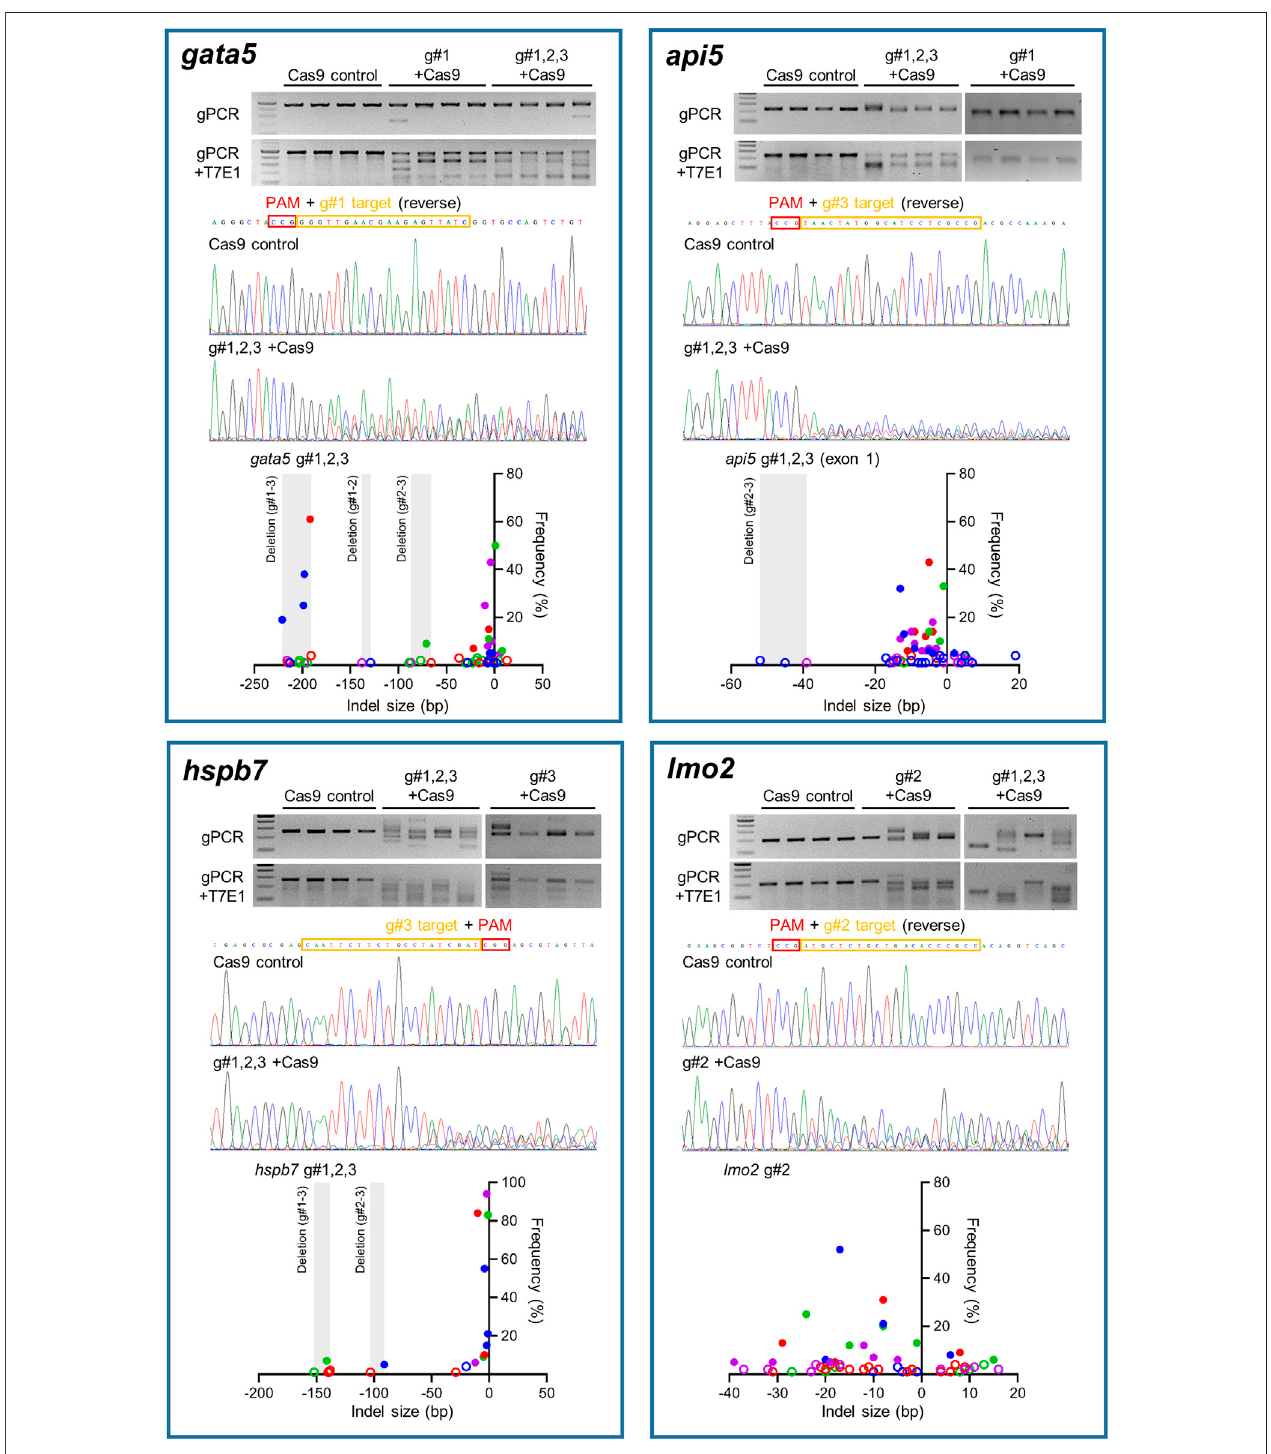
FIGURE2| Mutationef fi ciencyofthegRNAsforeachcandidategene.Datafor gata5 areshownintopleftpanel, api5 intoprightpanel, hspb7 inbottomleftpanel, and lmo2 in bottom right panel. In each panel, the upper gel images show the bands obtained following targeted PCR of genomic DNA extracted from four individual animals injected with the two most effective CRISPR gRNAs + Cas9 (based on 2 dpf morphological analysis), compared with the Cas9 injected control animals. The lowergelimagesshowthesamesamplesfollowingT7E1assayundertakentorevealthecleavageofheteroduplexDNA.Thechromatogramimagesinthemiddleof each panel show the result ofSanger sequencing undertaken on representative genomic DNAsamplesfrom themost effective gRNA + Cas9, per gene, compared with that from a representative Cas9-injected control animal. The lower scatter plot graphs in each panel show the indel size and frequency in the PCR products from most